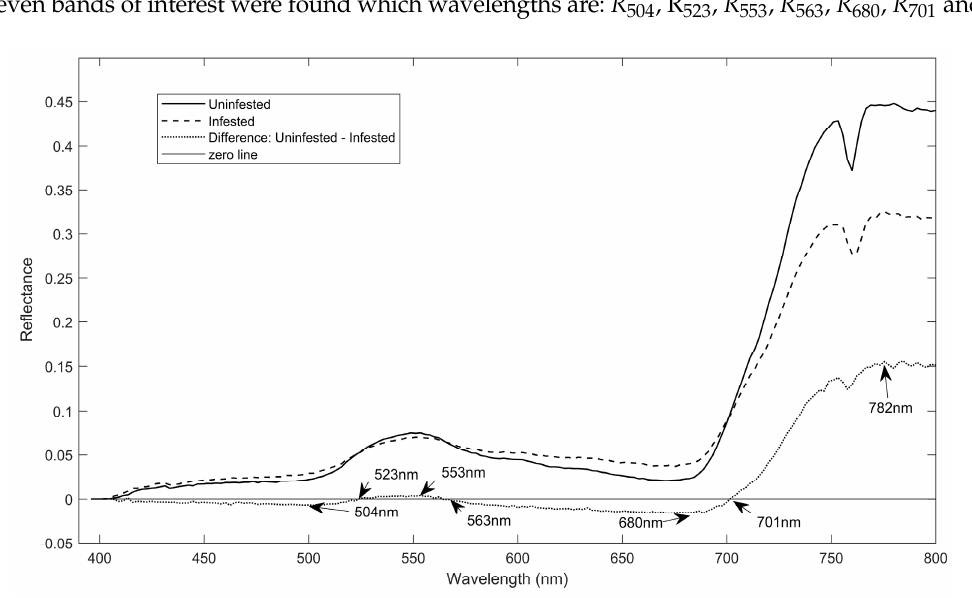
Figure A1. Mean spectral signature for different levels of vigour of the grapevine for the Chardonnay variety measured in December 2016 for wavelengths from 400 nm to 700 nm.